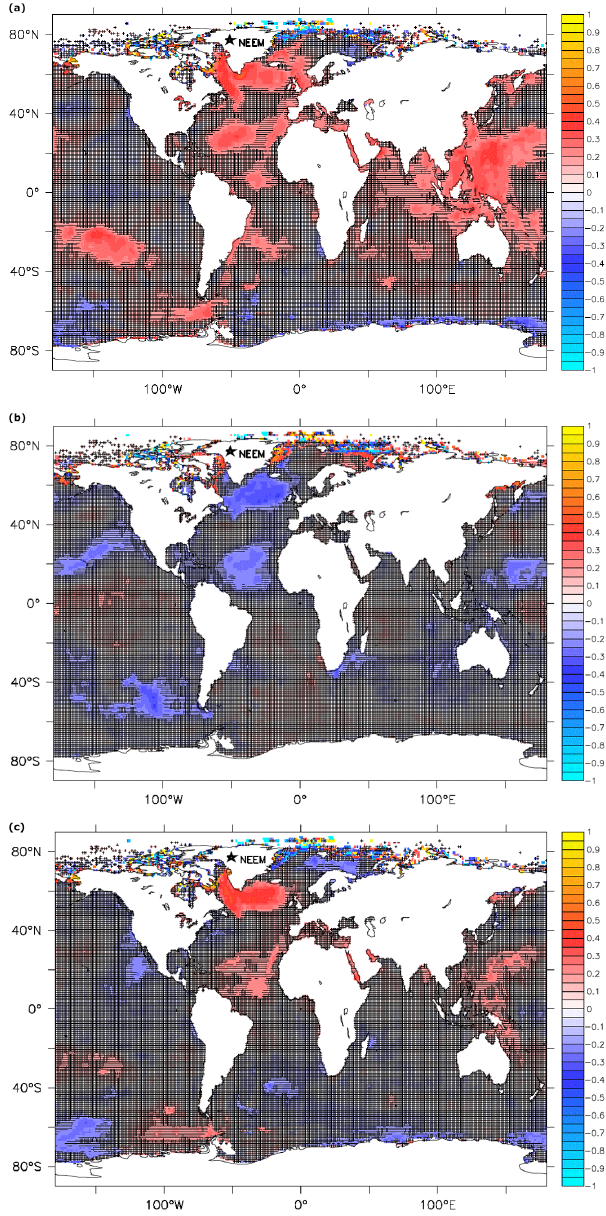
Figure 6. Correlation coefficients between NEEM δ 18 O, accumu- lation and deuterium excess records and HadSST gridded SST data, using 5-year smoothed data, for the period 1870–2010. The hatch- ing highlights areas where correlation coefficients are not signifi- cant at the 95% confidence level. From top to bottom: (a) δ 18 O, (b) accumulation and (c) deuterium